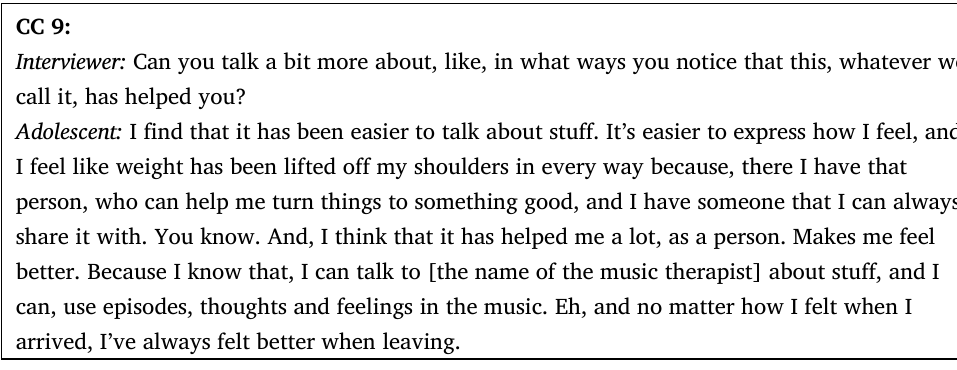
Fuhr and Stensæth. Voices 2022, 22(3).